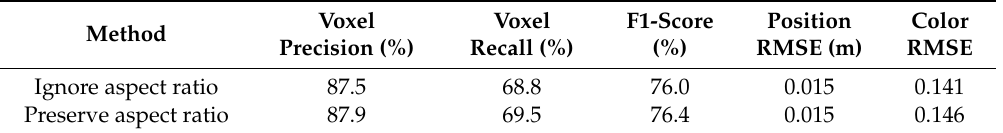
Table 3. Performance comparison between having the input image resized with the aspect ratio ignored vs.